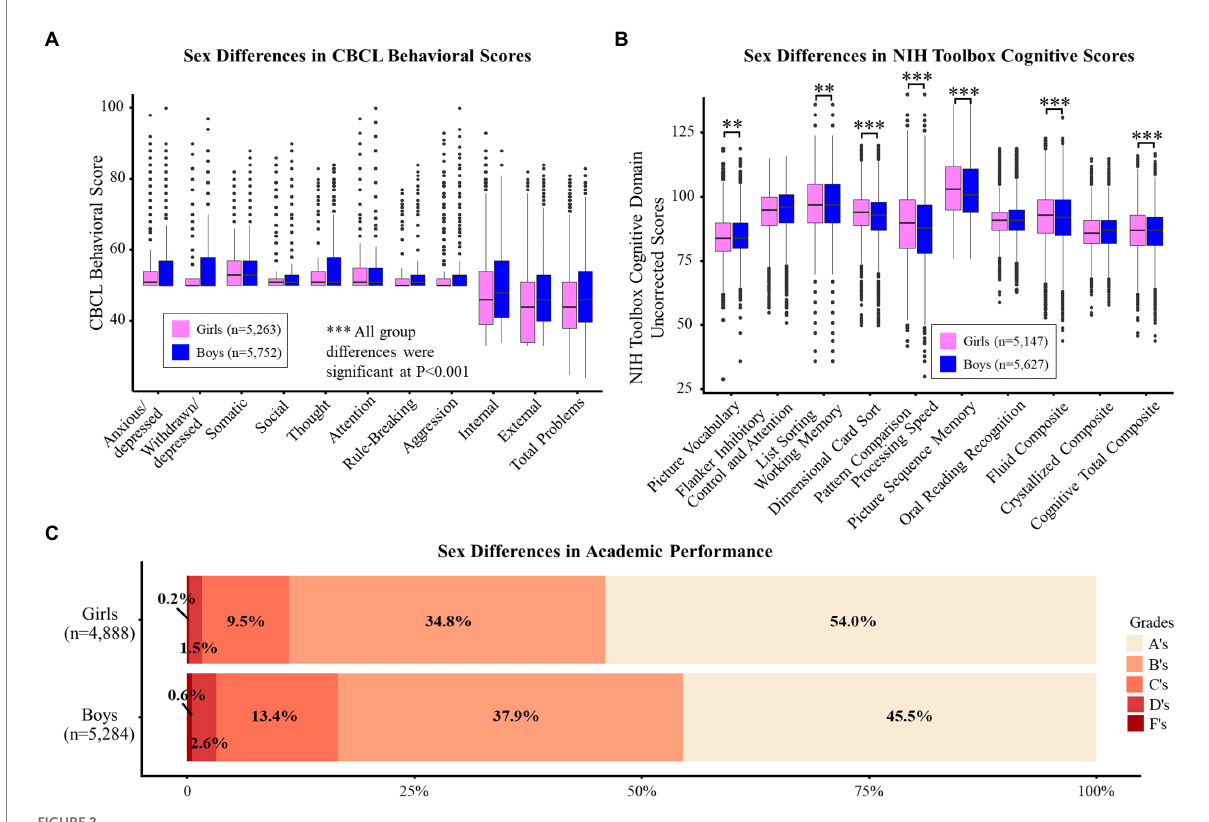
FIGURE 2 (A,B) display the unadjusted mean t -scores for each CBCL domain (A) and the uncorrected score for each NIH Toolbox Cognitive Domain (B) by sex. Significant p -values are marked with asterisks (* <0.05, ** <0.01, *** <0.001). (C) displays the distribution of caregiver-reported academic grades by bullying and sex. Chi-square tests were used to determine the differences in distributions between and within groups. All comparisons were